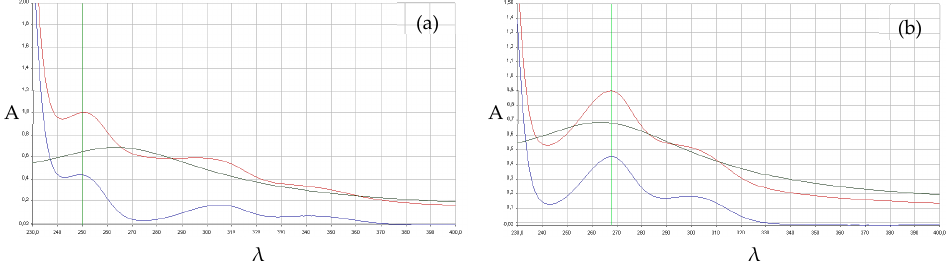
Figure 2. UV spectra of copper (II) solution (green track), ligand solution (blue track), and copper (II)/ligand 4:1 solution (red track). The experimental conditions are reported in Section 4.5. ( a ) compound 3 and ( b ) compound 4 . A = absorbance, λ = wavelength (nm).